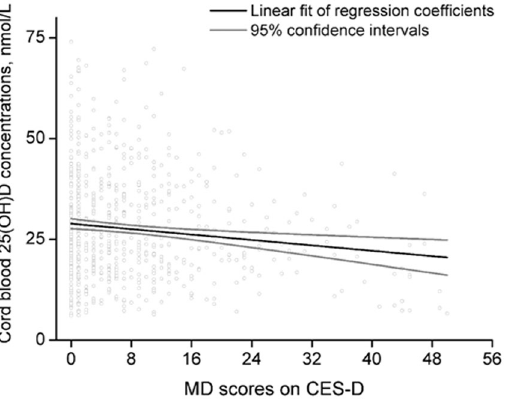
Figure 3. Linear relationship between maternal depression (MD) scores on CES-D and cord blood concentrations of 25(OH)D. The solid black line denotes the fit of the regression model; the solid grey line denotes the 95% CI. 25(OH)D, 25-hydroxyvitamin D; CES-D, Center for Epidemiological Studies Depression